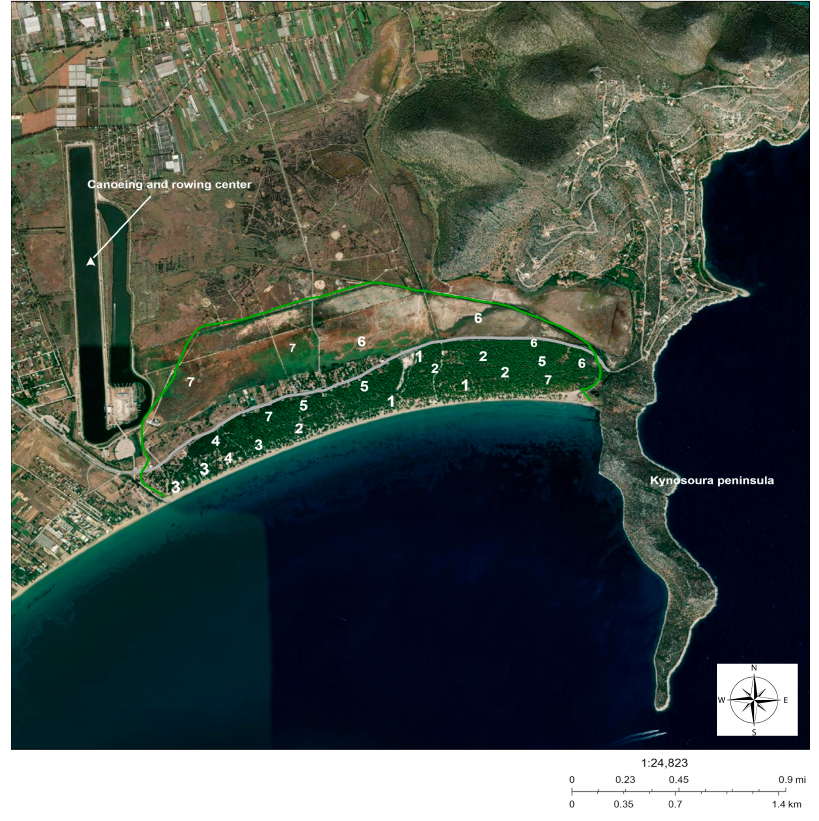
Figure 1. Schinias study area at the northeastern part of Attica, Greece. The grey line together with the sea front circumscribes the study area. The black line with a west–east direction indicates the road leading to the base of the Kynosoura Peninsula. The numbers show the habitats revealed in this study on the basis of their insect content.